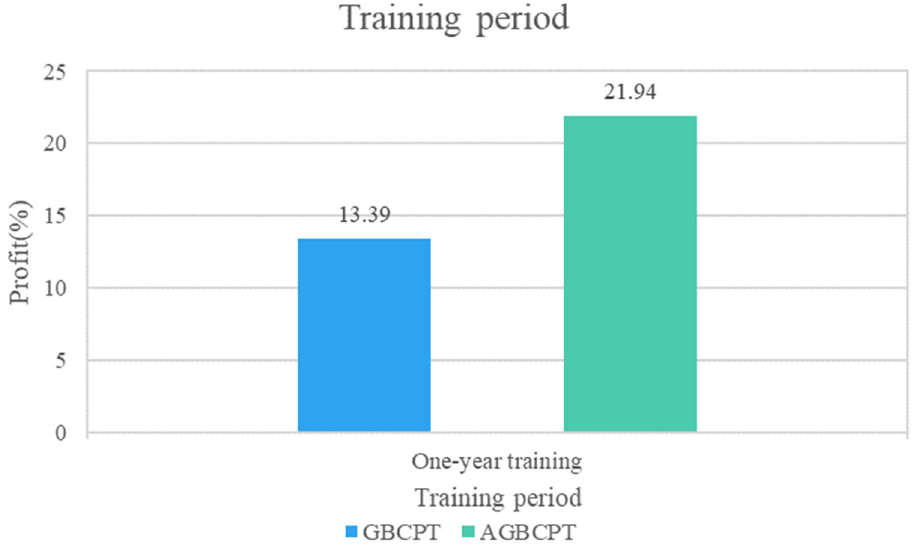
Figure 16. AGBCPT and GBCPT profits in training period.